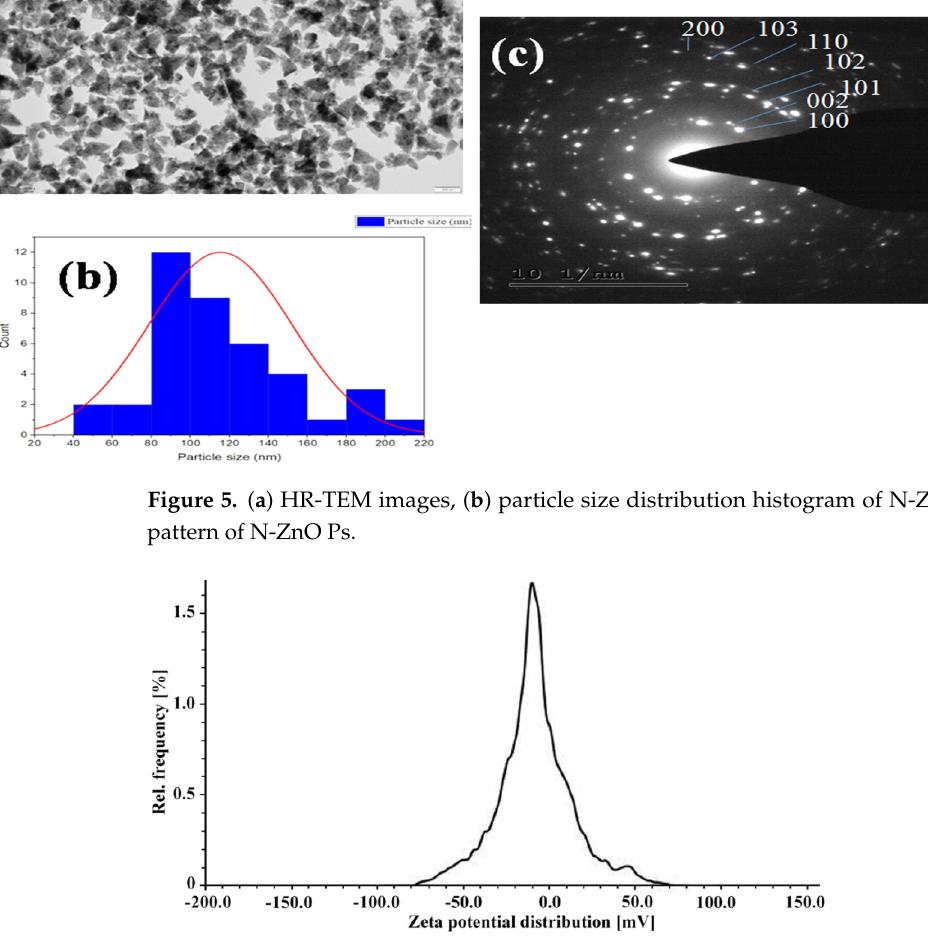
Figure 6. Zeta potential of the N-ZnO Ps.